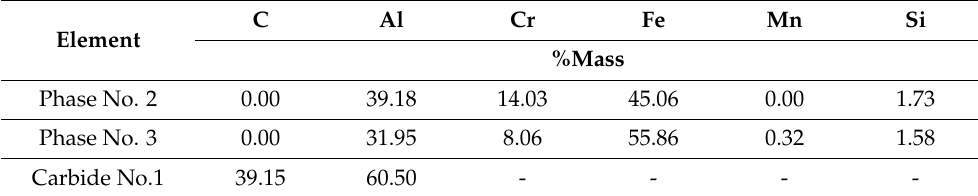
Table 3. Chemical composition of high-aluminum cast iron.